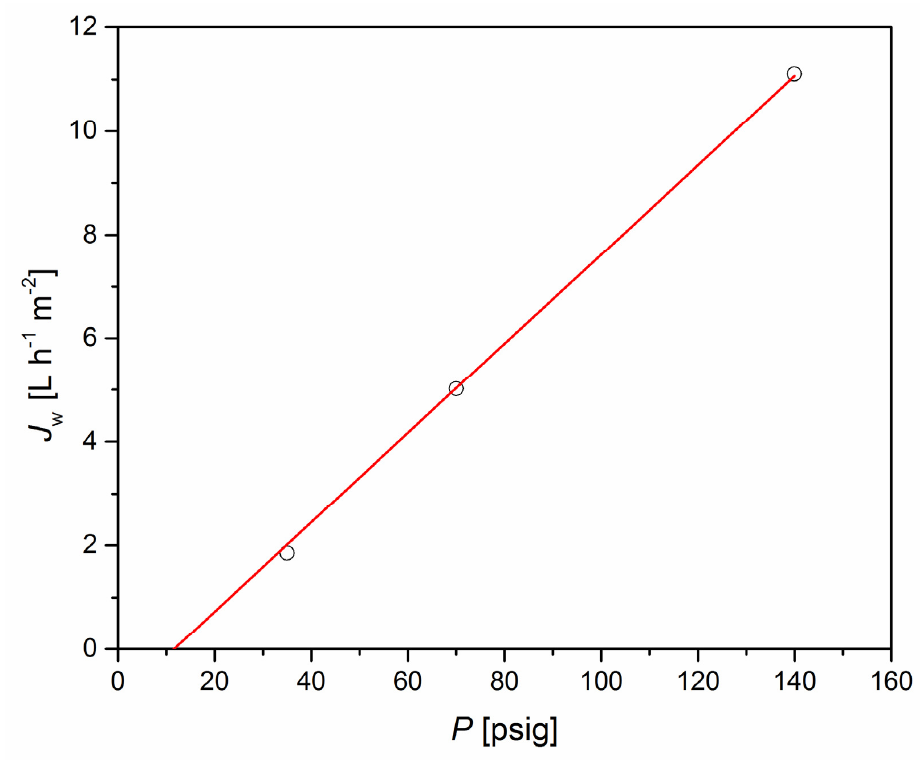
Figure 4. Water flux as a function of pressure in batch separation experiments with a 5 mS/cm mPSS solution using PS35 UF membrane.